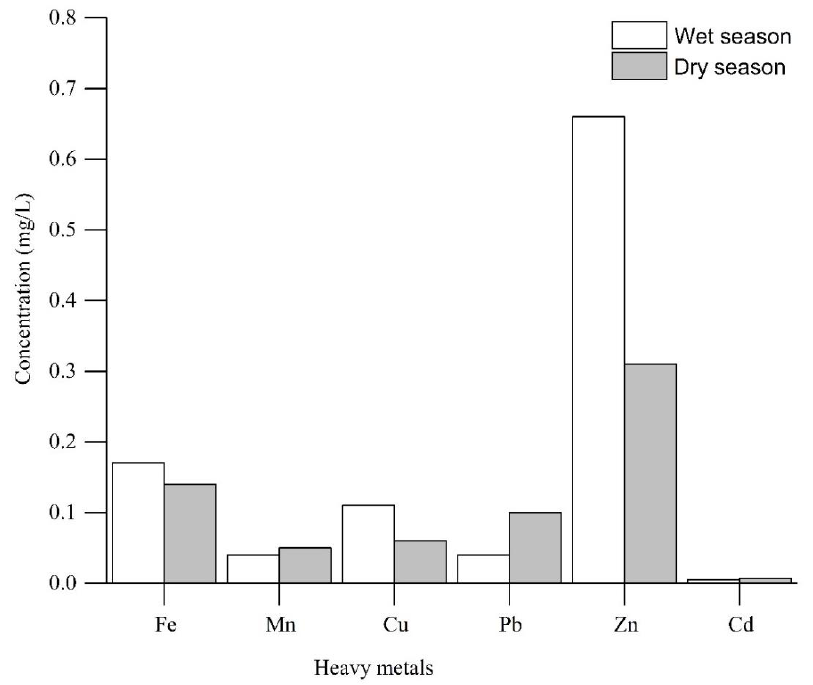
Figure 8. Average concentration of heavy metals.